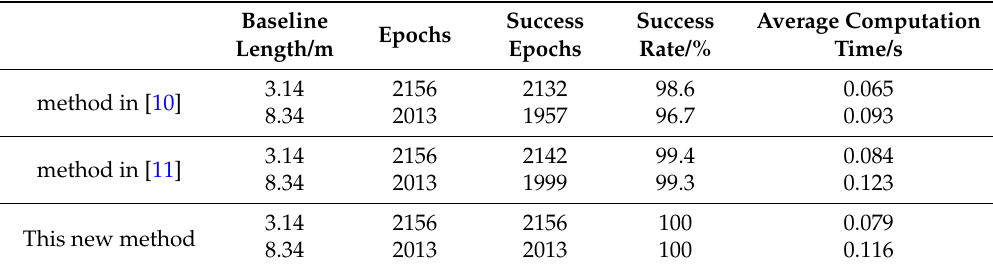
Table 1. Single frequency, single epoch success rate and average computation time comparison.